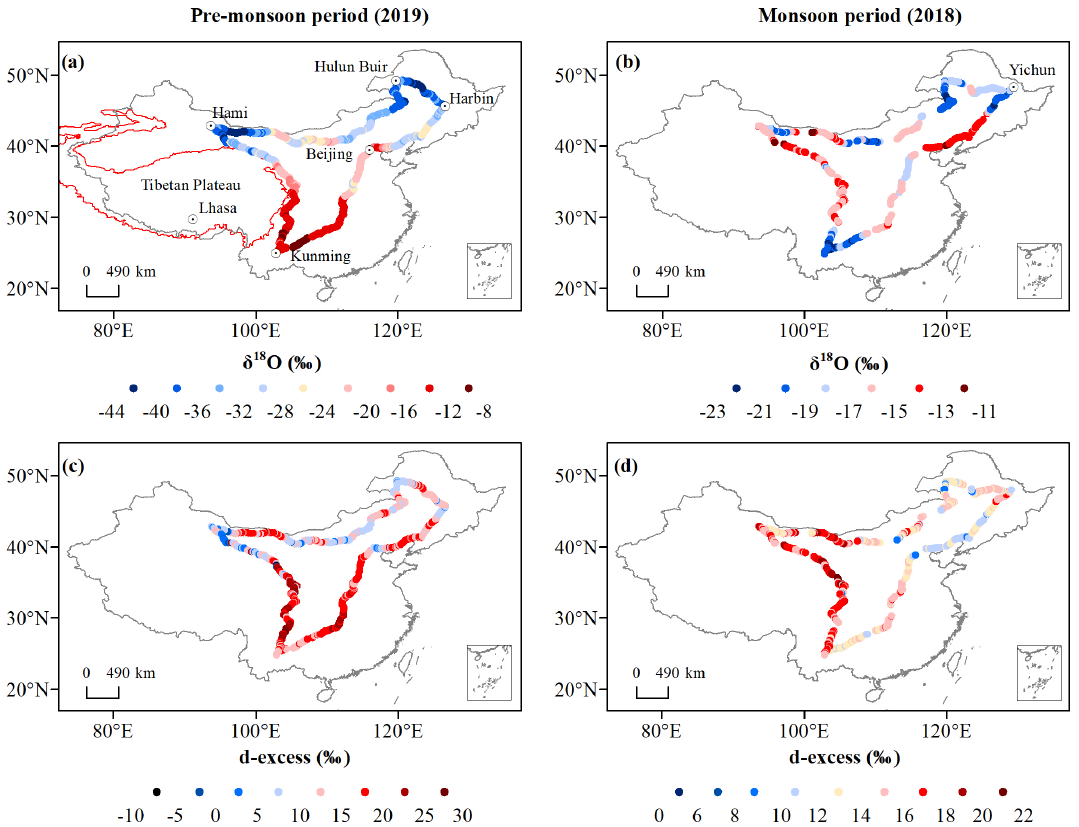
Figure 5. Spatial distribution of vapor δ 18 O (a, b) and d-excess (c, d) during the pre-monsoon period (a, c) and the monsoon period (b, d) . Table 2. The relative contribution (in fraction) of spatial variations for a given season ( a _seaso ) and of synoptic-scale variations ( a _synoptic ) to the daily variations of q and δ 2 H simulated by Iso-GSM and retrievals from IASI. We checked that the sum of a _seaso and a _synoptic is always 1. The two values indicate the lower and upper bounds as calculated from Eqs. (8) and (9). Period Data Variables Contributions a _seaso a